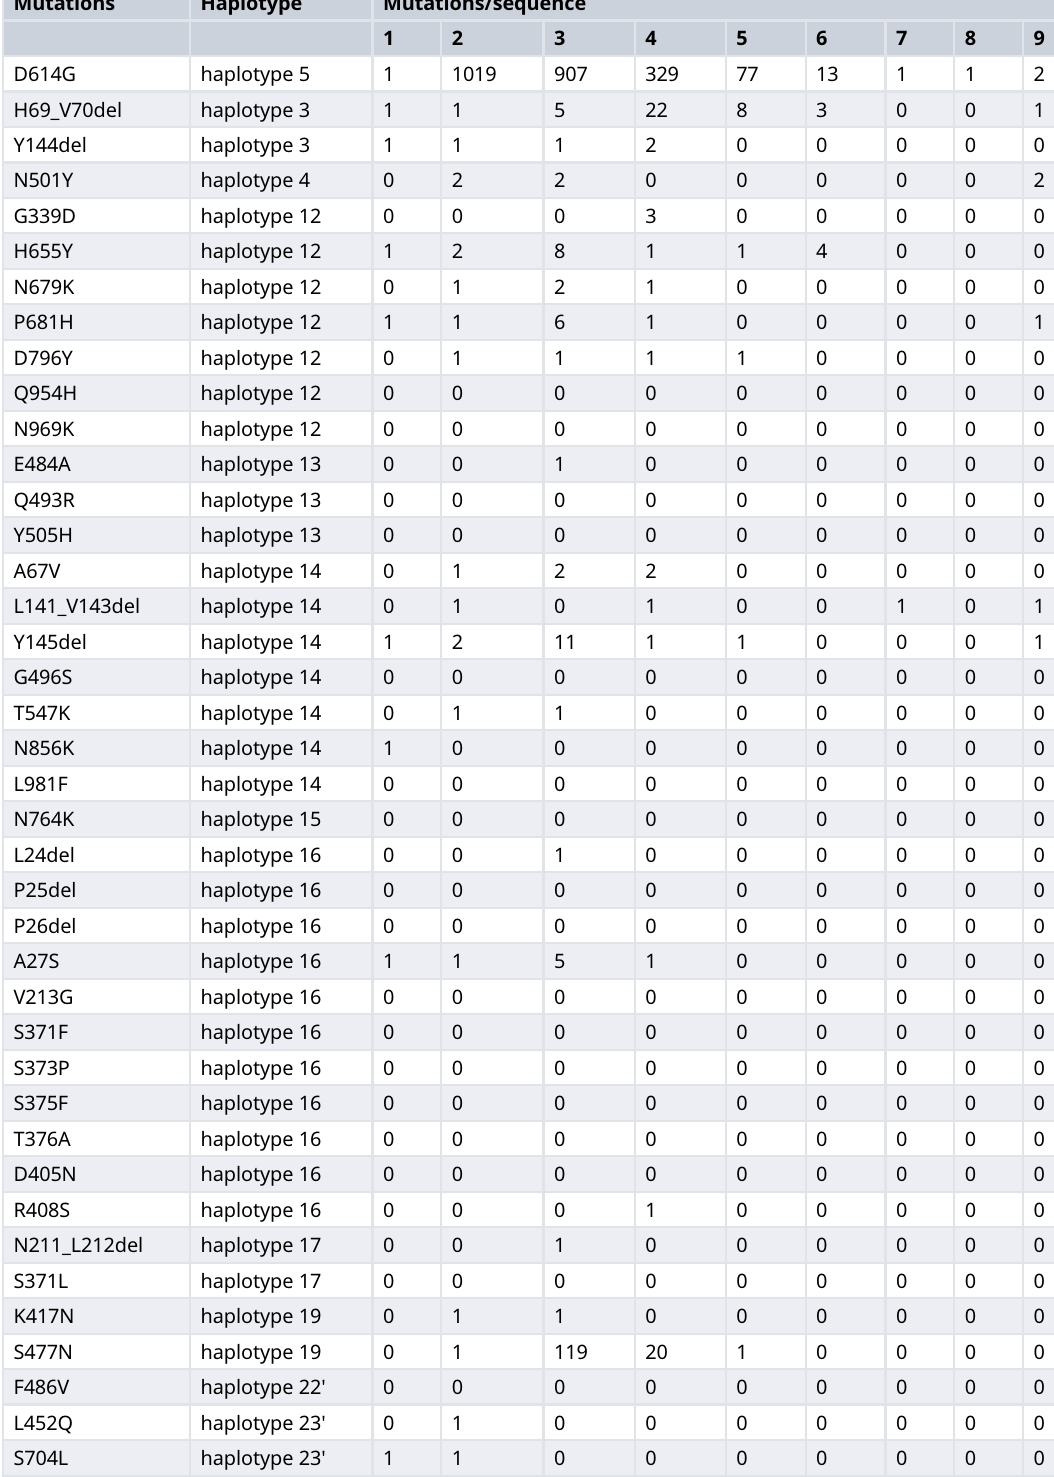
Table 2. Presence of S-protein mutations of VOC Omicron in 2020 prior to VOC emergence. The table lists the number of distinct mutant combinations harboring VOC Omicron markers out of the total 2,942 identified in a set of 137,605 sequences of the S-protein retrieved worldwide on November 14, 2020 (Showers et al., 2022).